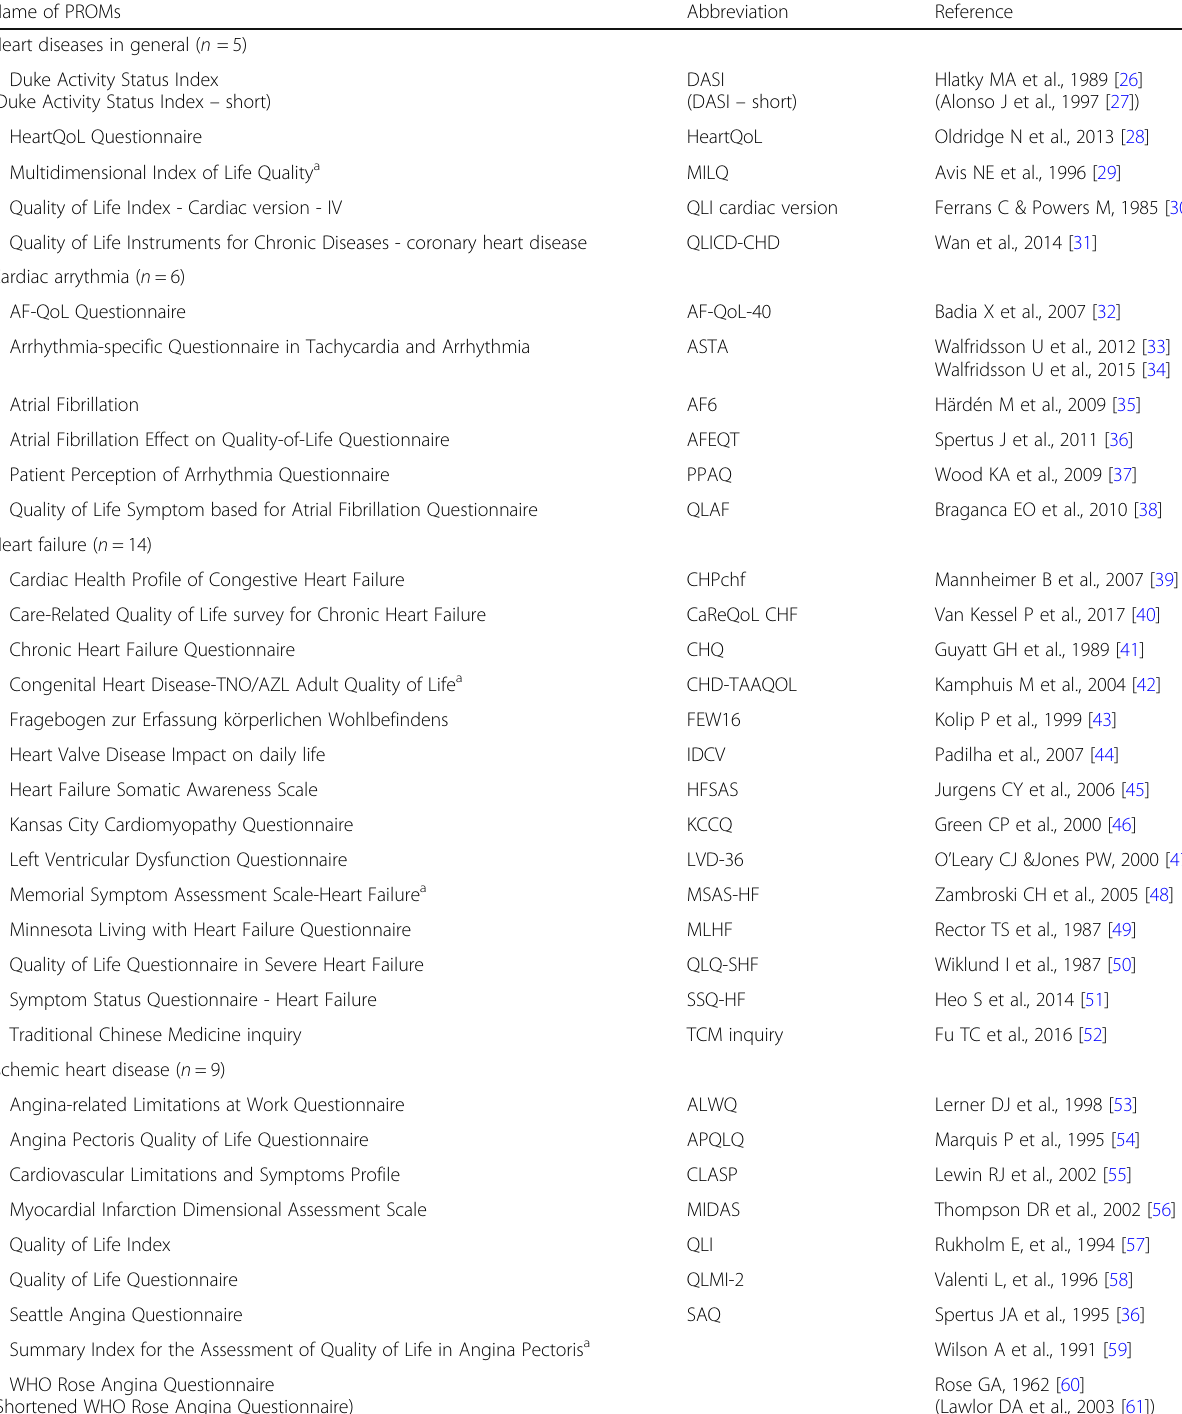
Table 1 Overview of the heart-disease specific PROMs identified by the systematic literature search ( N =